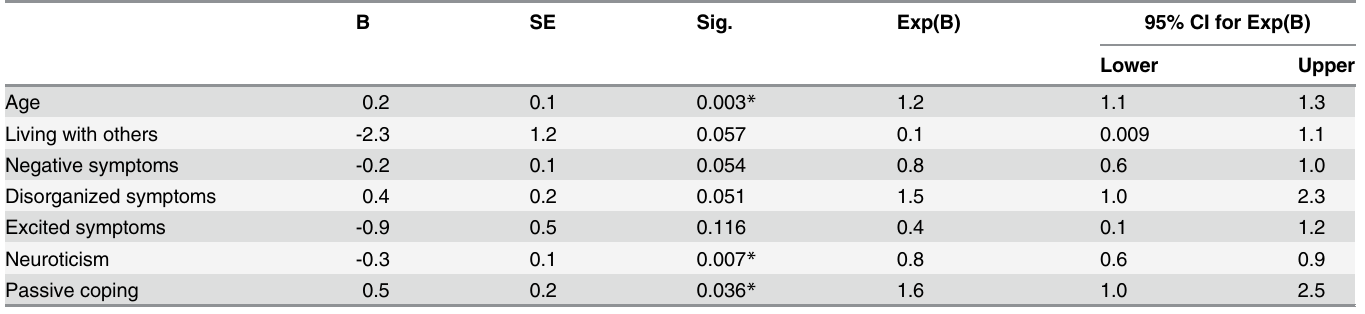
Table 2. Results of Cox regression analysis of complete cases in original dataset (n = 7).